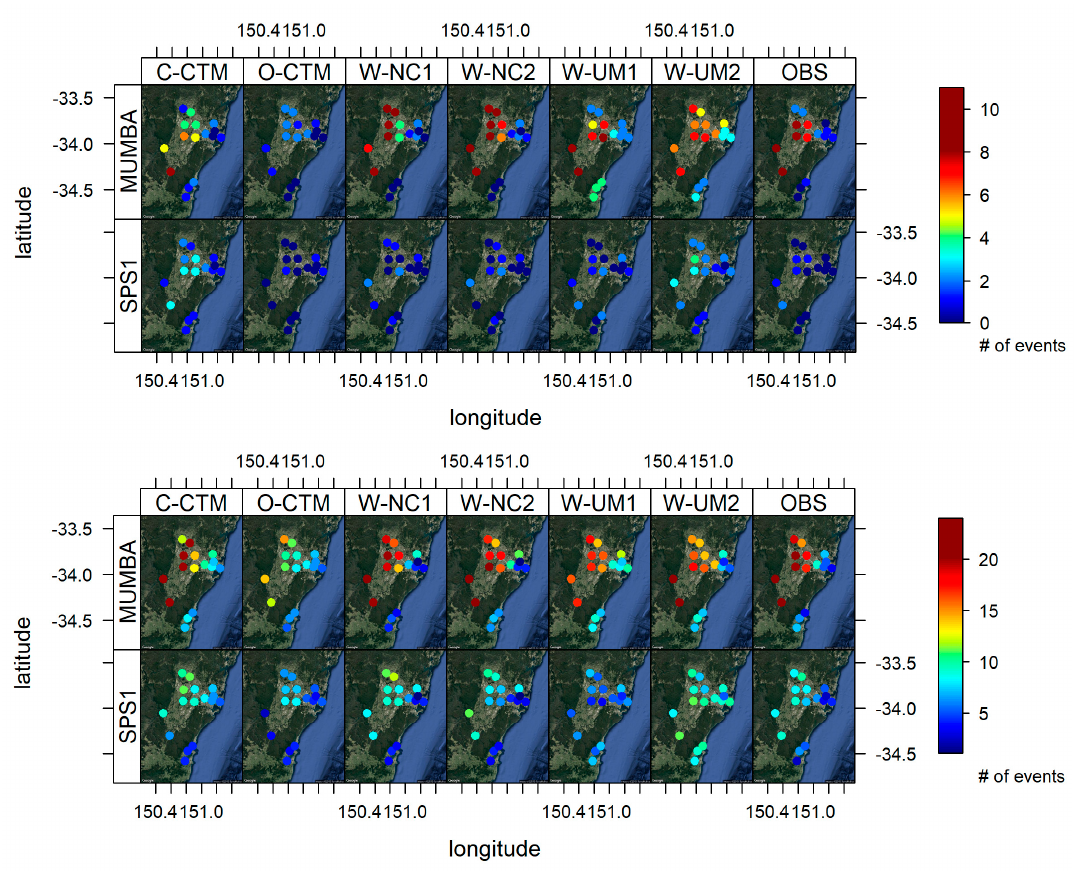
Figure 6. Maps of the number of observed (right-most column) and modelled events for daily maximum ozone > 60 ppb (top panel) and > 40 ppb (bottom panel).